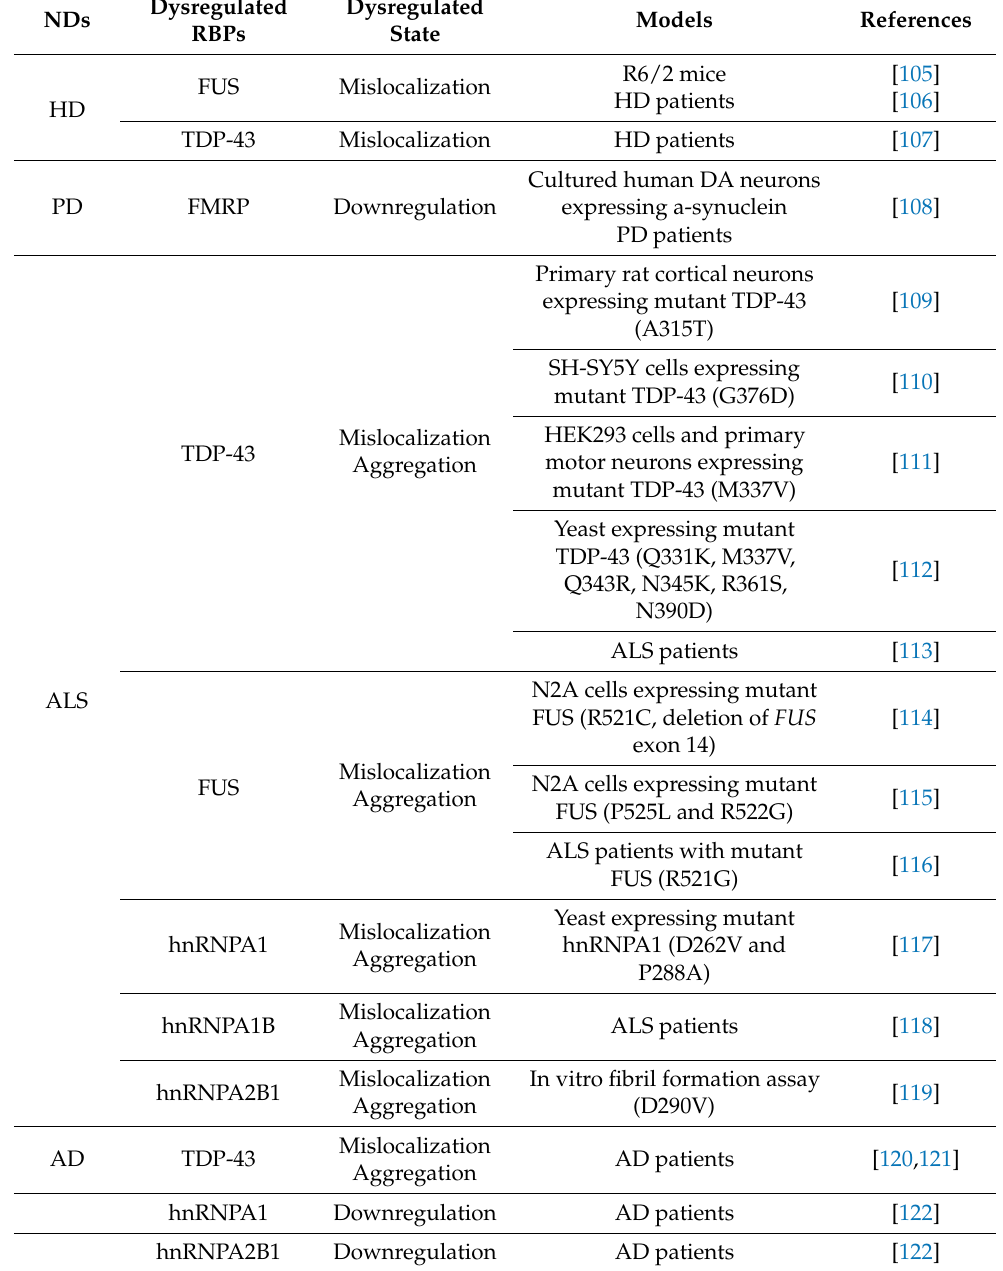
Table 3. List of dysregulated RNA binding proteins (RBPs) in neurodegenerative diseases